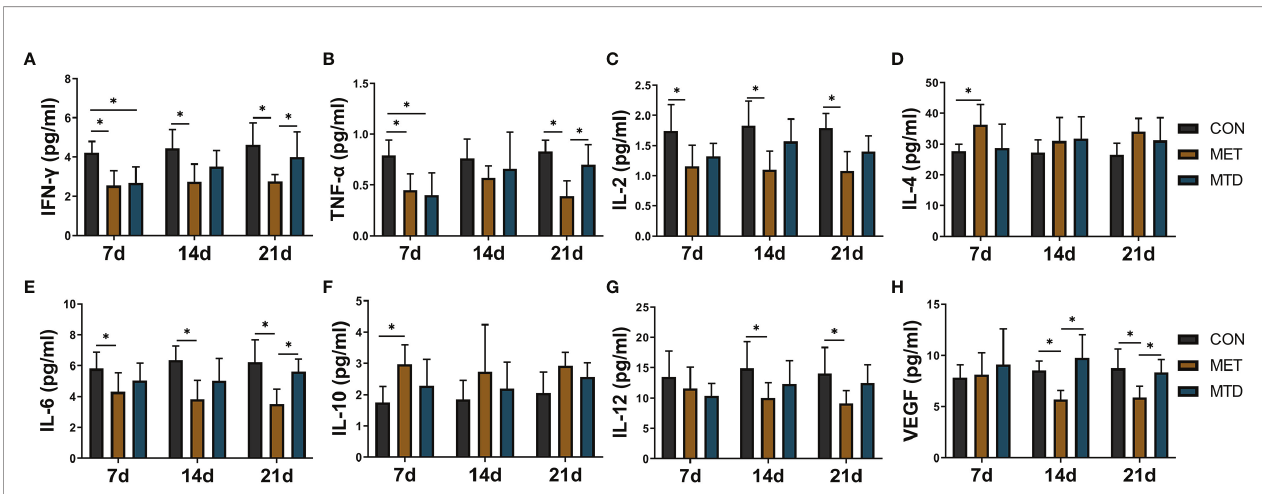
FIGURE 3 | The concentrations of serum cytokines in the mice treated with different dosages of CAP. The levels of (A) IFN- g , (B) TNF- a , (C) IL-2, (D) IL-4, (E) IL-6, (F) IL-10, (G) IL-12, and (H) VEGF were detected by Luminex assay. CON: control groups, in which mice received 0.9% normal saline. MET: CAP-treated groups, in which mice received metronomic chemotherapy dose of CAP (100 mg/kg/d). MTD: CAP-treated groups, in which mice received maximum tolerated dose of CAP (400 mg/kg/d). Data are shown as mean ± SD. * P <